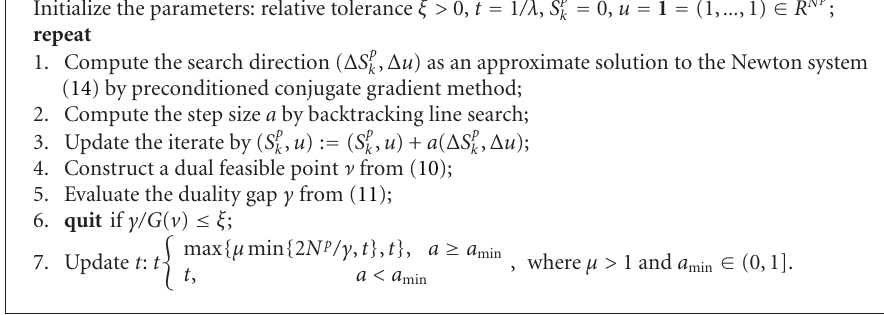
Algorithm 1: TNIPM algorithm for BLT reconstruction at the k th mesh level.